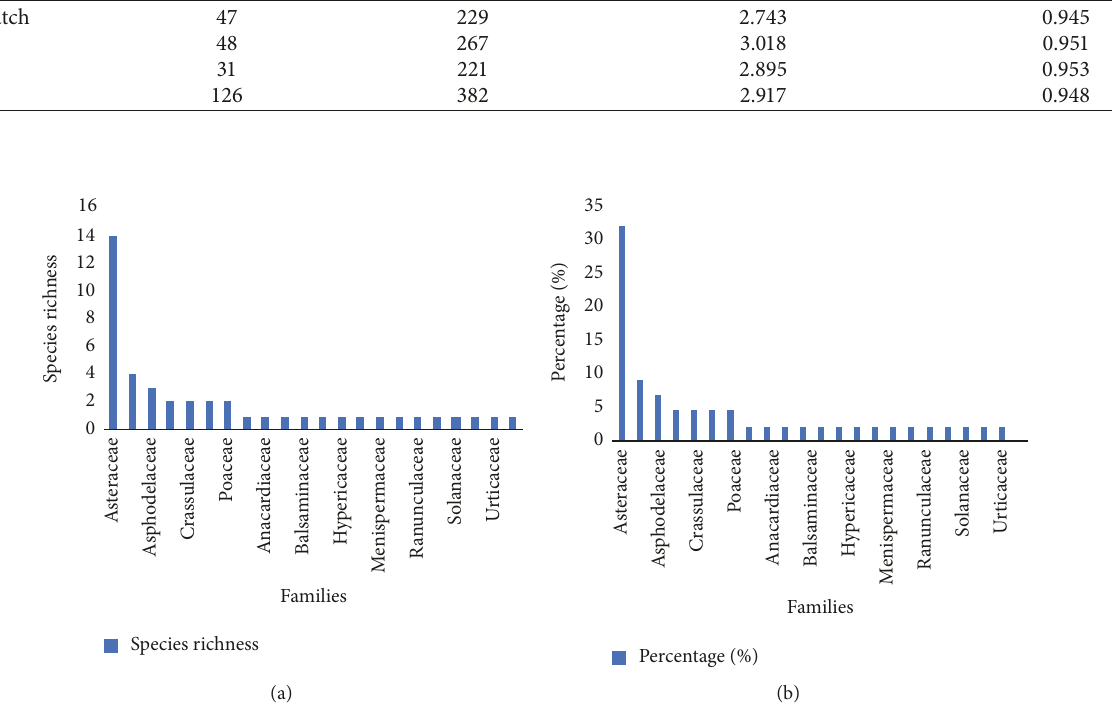
Figure 5: The percentage proportion (b) and species richness (a) of above-ground endemic plant species within the